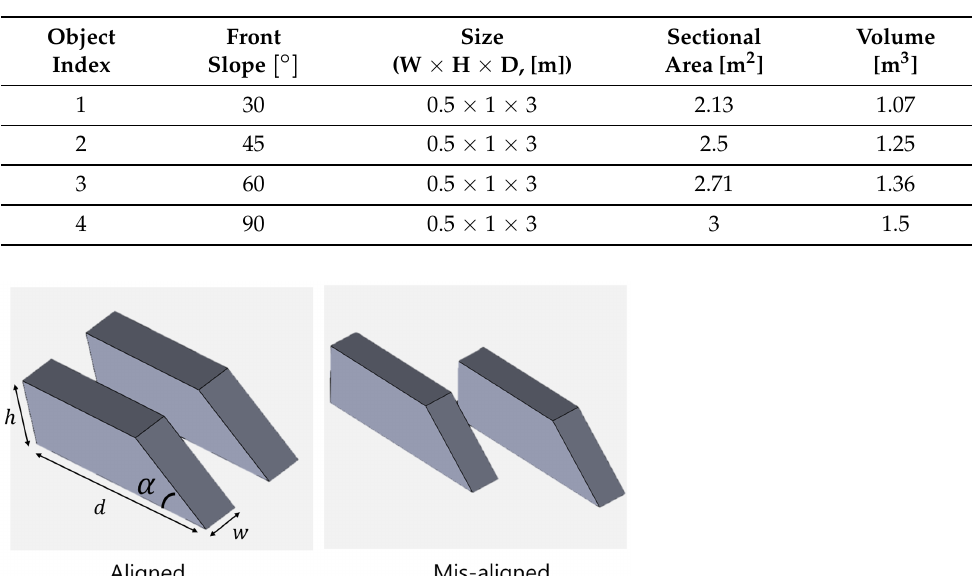
Table 2. Dimensions of the objects used in the simulation.